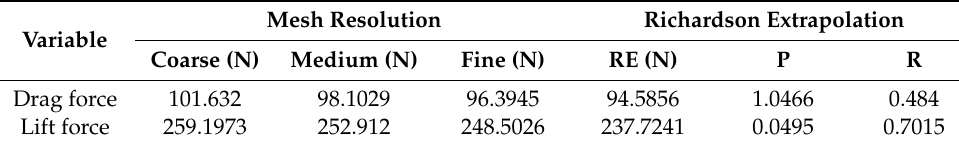
Table 5. Mesh verification for RANS.